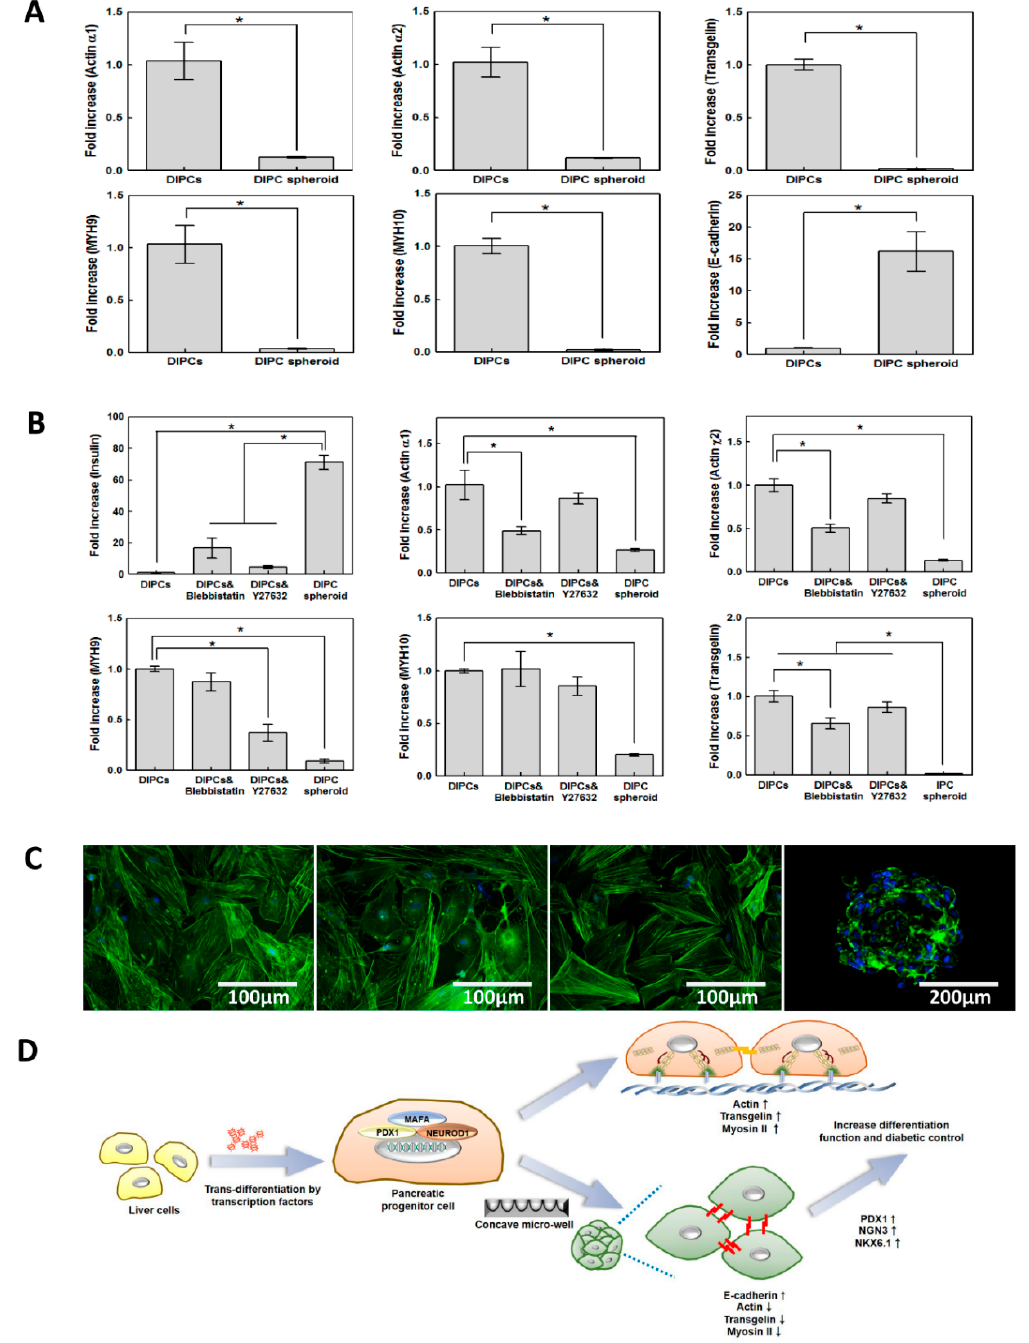
Figure 4. Mechanistic analysis of β -cell di ff erentiation of DIPC and DIPC spheroid cultures ( A ) Comparison of cytoskeletal and E-cadherin gene expression in DIPCs and DIPC spheroids ( n = 4). ( B ) The e ff ect of treatment with actin and myosin inhibitors on DIPC di ff erentiation ( n = 4). The gene expression of actin, myosin, and insulin is compared among DIPCs, treated DIPCs, and DIPC spheroids. DIPCs treated with both drugs showed increased insulin gene expression compared to untreated DIPCs, and blebbistatin-treated DIPCs had higher induction of di ff erentiation. * indicates a significant di ff erence between two groups ( p < 0.05). ( C ) Images of actin in DIPC, treated DIPC, and spheroid groups. Alexa-488 phalloidin was used to visualize F-actin (green); DAPI was used as a nuclear stain (cyan). ( D ) Illustration of the mechanism by which spheroid formation a ff ects insulin production. DIPC spheroid formation reduces actin–myosin interactions and increases cell–cell interactions (E-cadherin), which induce insulin and pancreatic transcription factor expression.